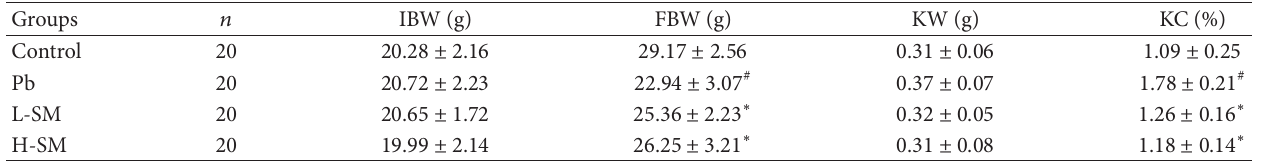
Figure 4: Effects of SM injection on activities of SOD, GSH-Px, and on the concentrations of MDA. Samples were obtained from the kidney homogenate of the experimental mice. Data are expressed as mean ± SD of 20 mice. ## 𝑃 < 0.01 , compared with control group; ∗ 𝑃 < 0.05 , compared with Pb group; ∗∗ 𝑃 < 0.01 , compared with Pb group. Table 1: Effects of SM injection on body weight and kidney